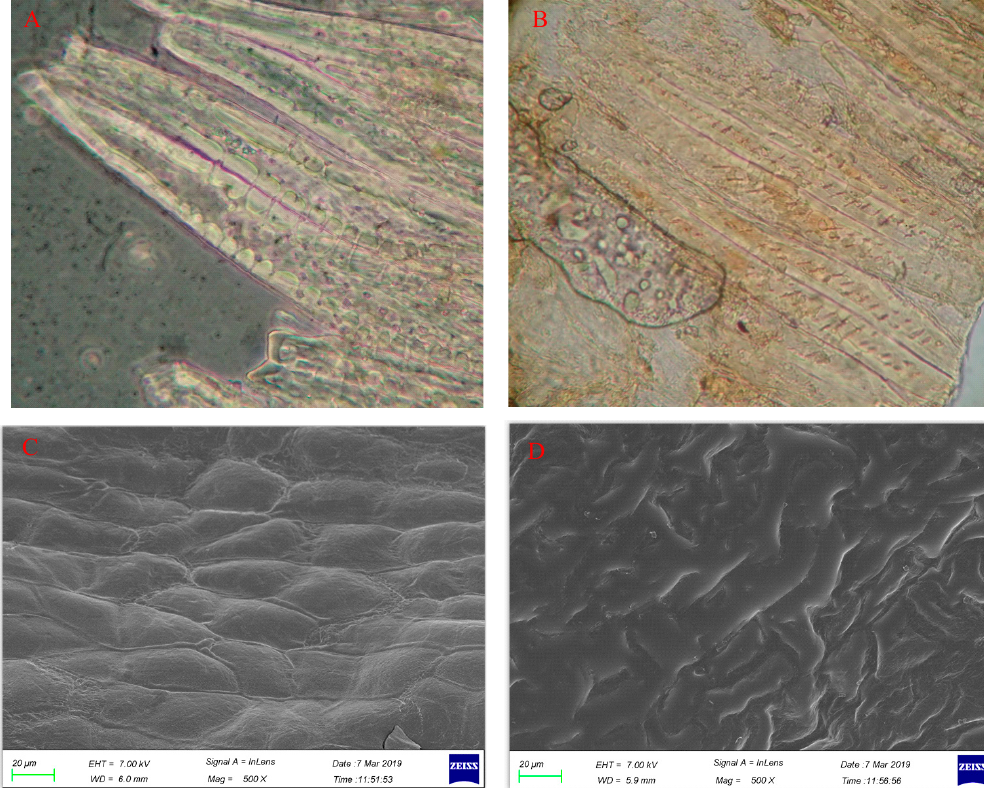
Figure 1. Microstructure of CS. ( A ): optical micrograph of unroasted CS (×1000); ( B ): optical micrograph of lightly roasted CS (×1000); ( C ): SEM graph of unroasted CS (×500); ( D ): SEM graph of deep-roasted CS (×500).